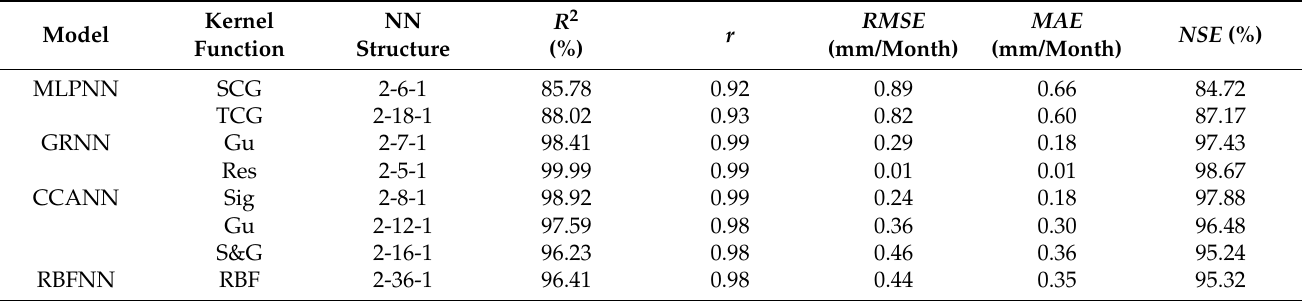
Table 4. Summary outlier of the selected neural network-based ML